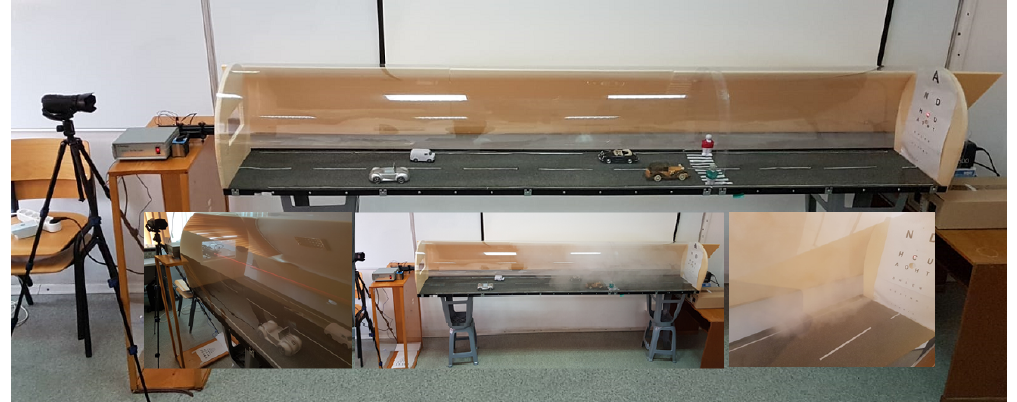
Figure 8. Laboratory